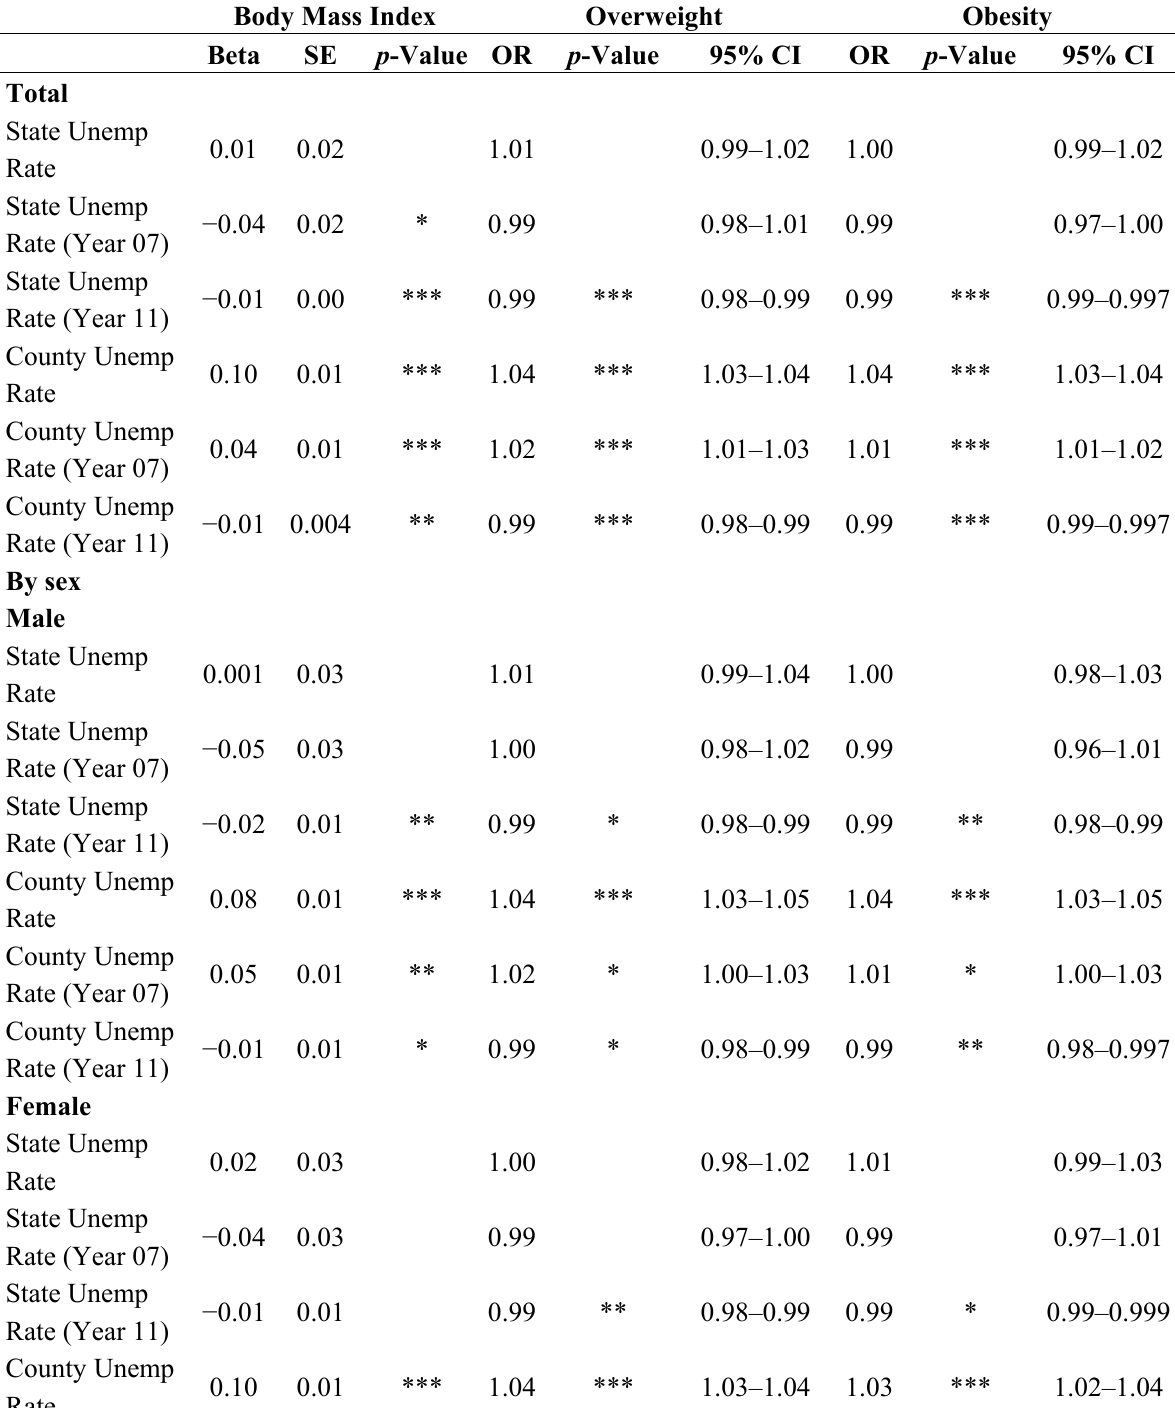
Table 5. Pooled analysis of relationship between body mass index, body weight status and state- and county unemployment rates in the BRFSS adults in 2007, 2009 and 2011 by participant